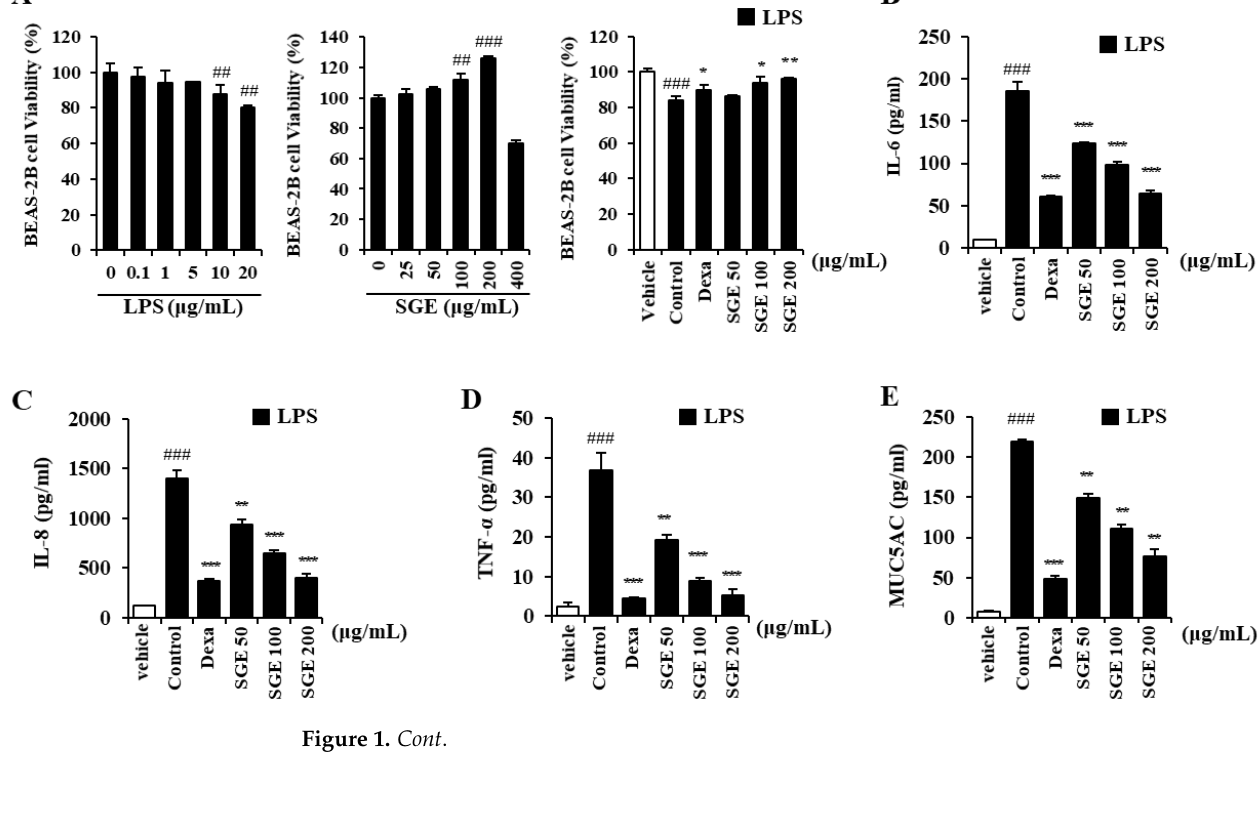
Figure 1. Effects of S. grosvenorii extract (SGE) on cytotoxicity and pro-inflammatory cytokine pro- duction in LPS-induced BEAS-2B cells. ( A ) Cytotoxicity of LPS and SGE in BEAS-2B cells was meas- ured using the CCK-8 assay. ( B – E ) BEAS- 2B cells were treated with LPS at 20 μg/mL and SGE at 50, 100, or 200 mg/mL for 24 h. Cytokines (IL-6, IL-8, TNF- α) and MUC5AC were measured using ELISA. ( F ) The relative expression of mRNA of the genes for IL- 1β, IL -6, IL-8, TNF- α, IL -17, CXCL1, and IRAK1 in the LPS-stimulated cells. The data are presented as means ± SEM for three independ- ent experiments. ## p < 0.01, ### p < 0.001 compared to the vehicle group. * p < 0.05, ** p < 0.01, *** p < 0.001 compared to the control group. Dexa, dexamethasone.